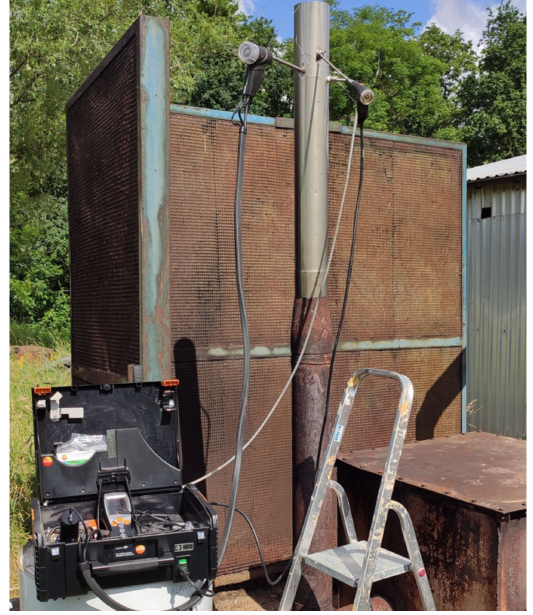
Figure 2. Measuring station located in the exhaust gas system.